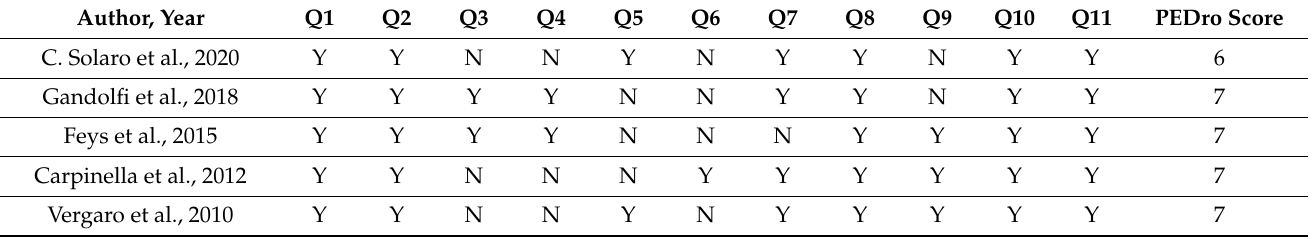
Table 2. Quality assessment of the RCT studies that were included using the PEDro Checklist.